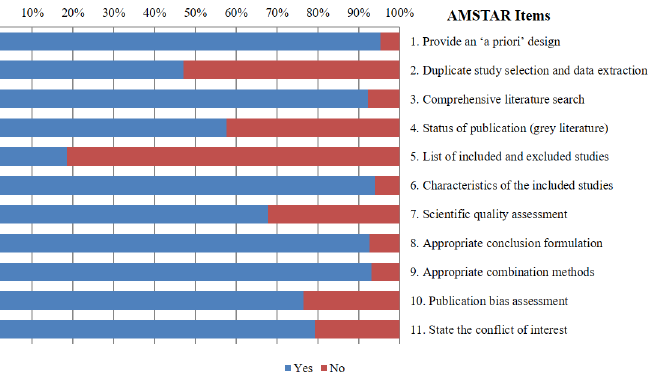
Fig 3. Individual items of and adherence to the AMSTAR checklist. A higher percentage indicates a better adherence. “ Yes ” means that the item is fulfilled; “ No ” means that the item is not fulfilled or